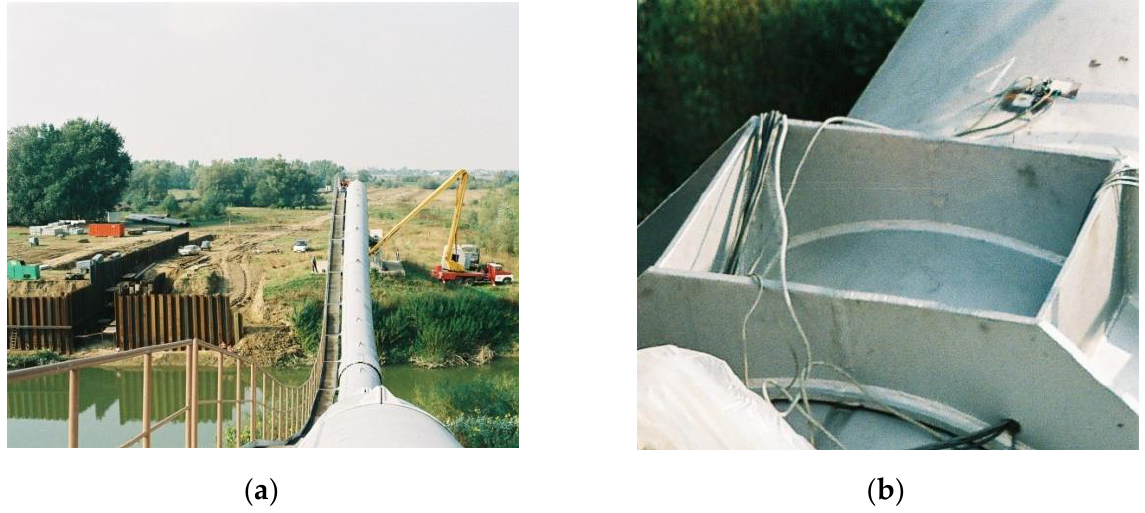
Figure 5. ( a ) View on the self-supporting pipeline in the direction of gas flow; ( b ) Detail of the applied strain gauges at the foundation footing.